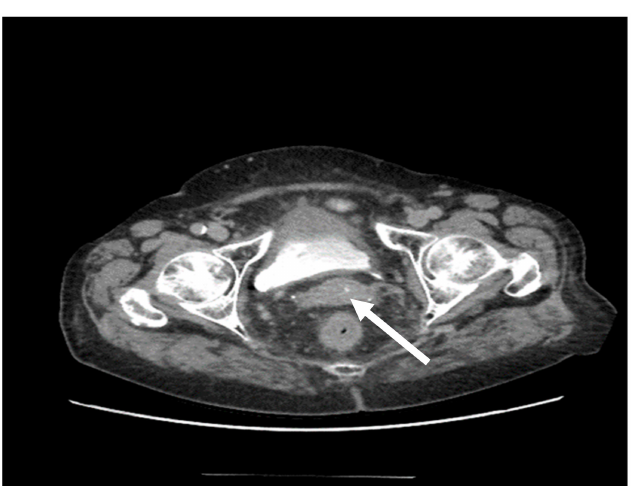
Figure 3. The 29-month CT scan, normal-looking cervix, post-chemotherapy and post-radiotherapy for a uterine cervix primitive non-Hodgkin